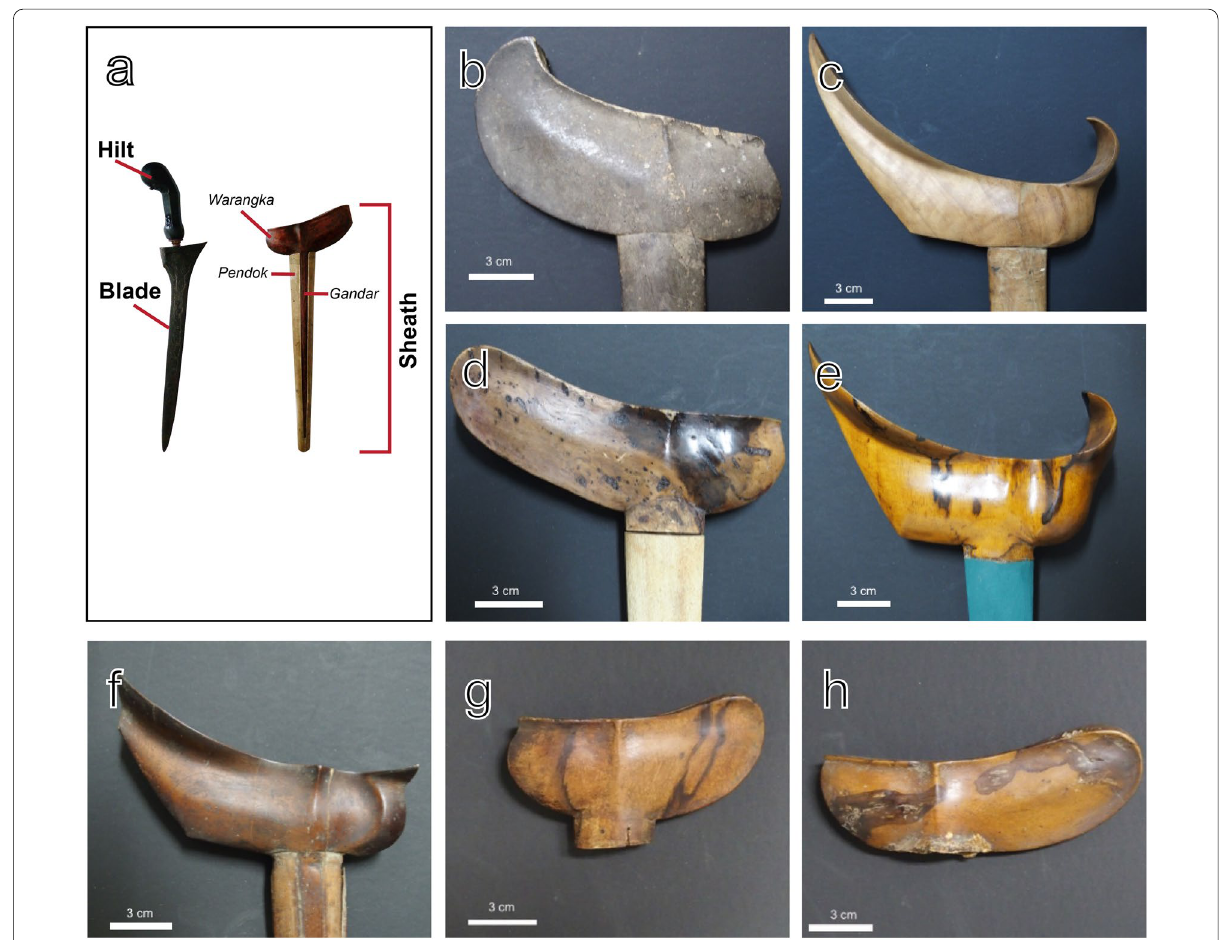
Fig. 1 a Definition of the kris main parts. Photographs of the kris sheaths: b 1, c 2, d 3, e 4, f 5, g 6, and h